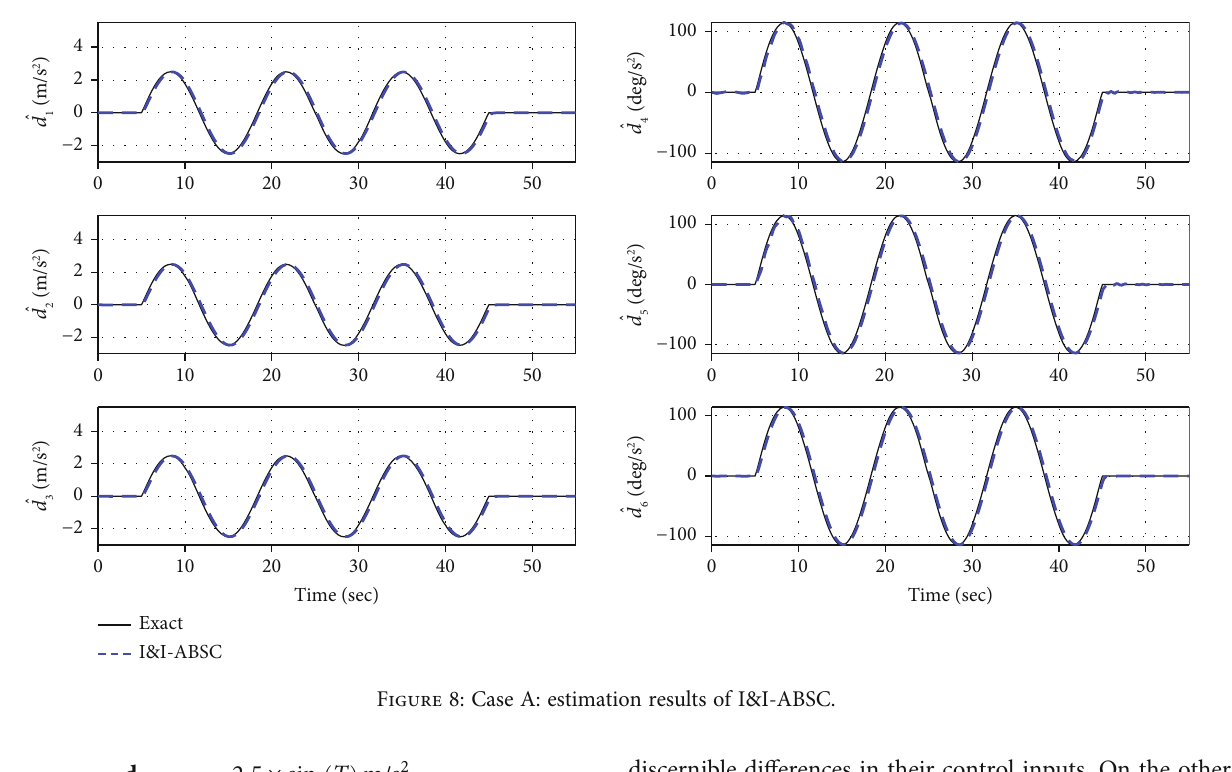
Figure 7: Case A: estimation results of